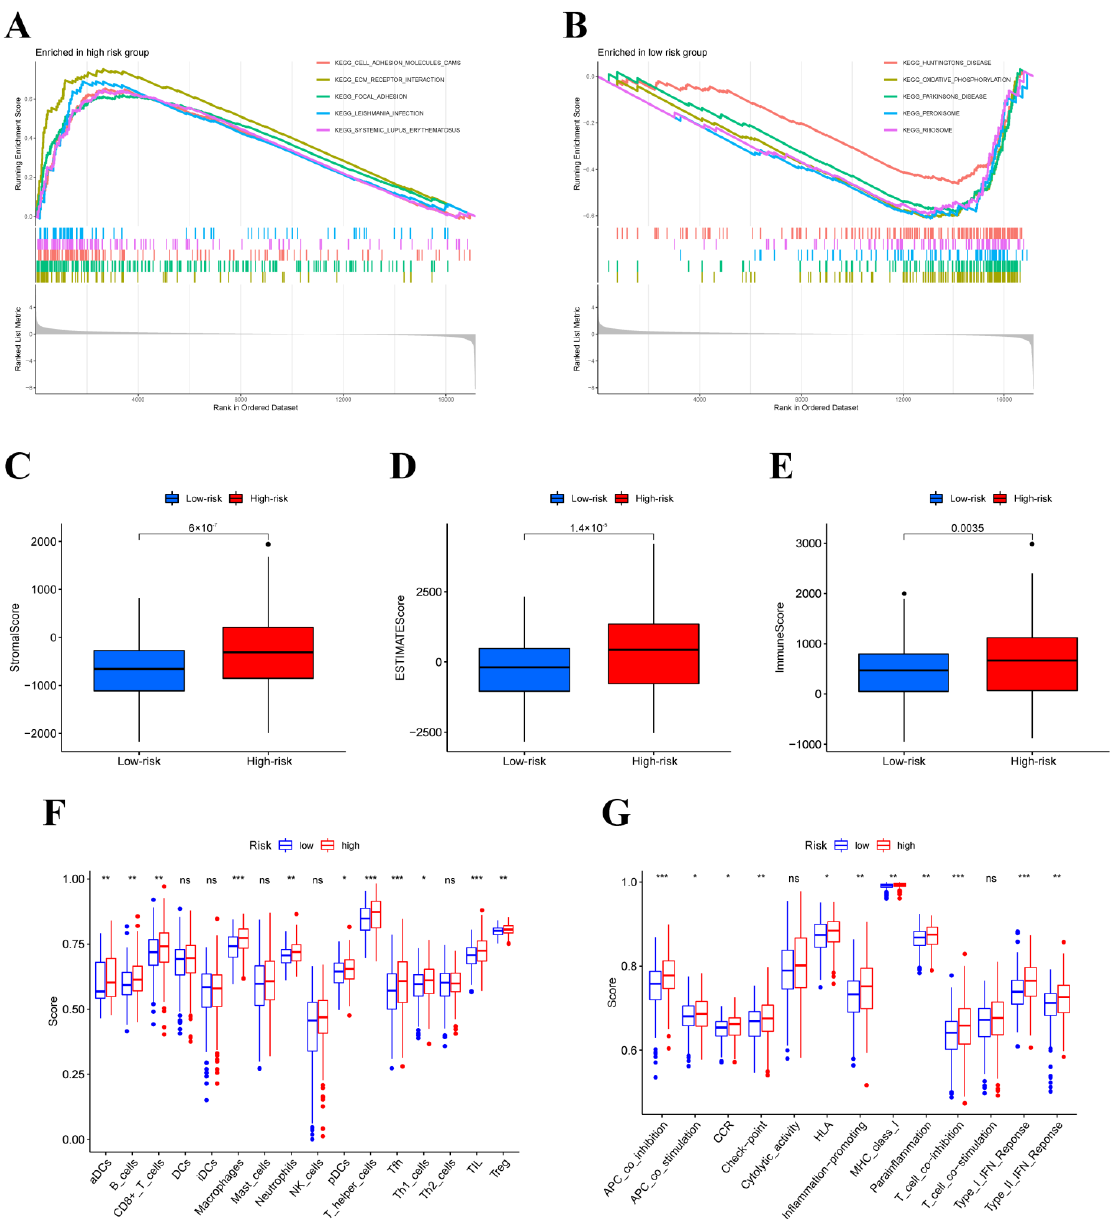
Figure 5. The gene set enrichment analysis, and estimation of immune cell infiltration in different risk groups. GSEA was performed to predict the potential functions and pathways in high-risk group ( A ) and low-risk group ( B ). ( C – E ) stromal score, immune score and ESTIMATE scores in high-risk and low-risk groups were shown. ( F , G ) The difference between immune cells and immune-related functions between two risk groups. Adjusted p -values were shown as ns, not significant, * p < 0.05, ** p < 0.01, *** p <